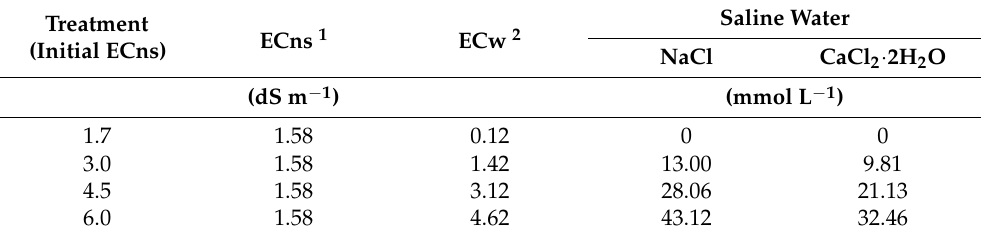
Table 1. Details of electrical conductivity values and concentrations of salts used to prepare different saline